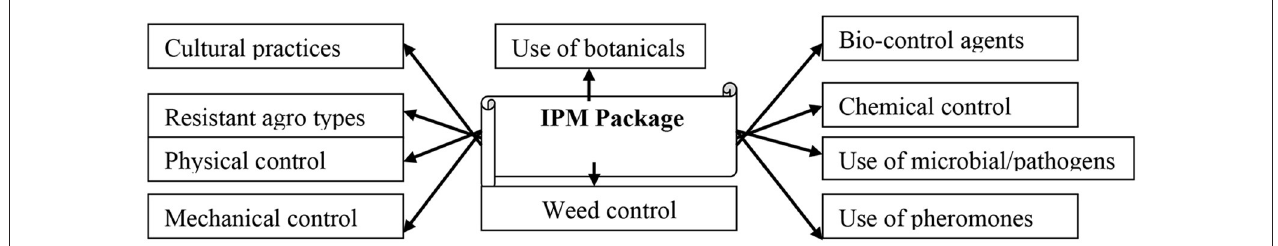
FIGURE 4 | IPM components for tea